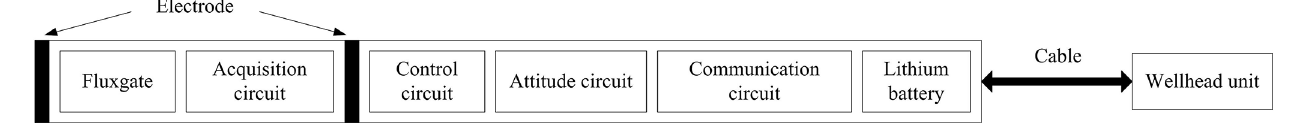
Figure 1. Structure of the hardware in the borehole EMR.